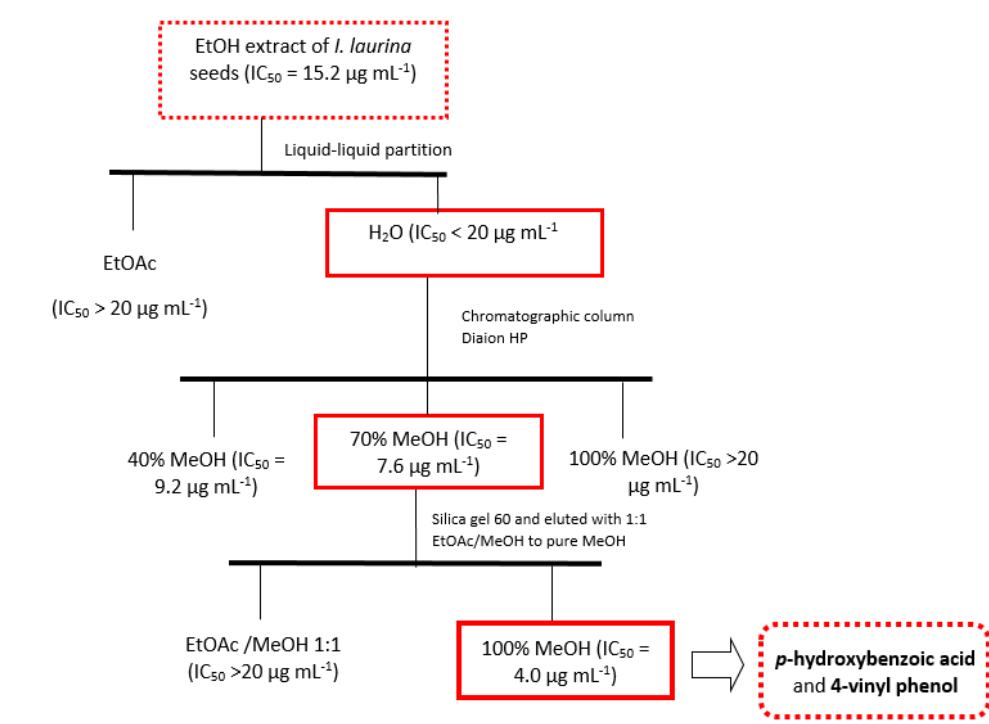
Figure 1. Flow chart showing extraction procedures used to obtain cytotoxic compounds from eth ‐ anolic extract of I. laurina seeds.